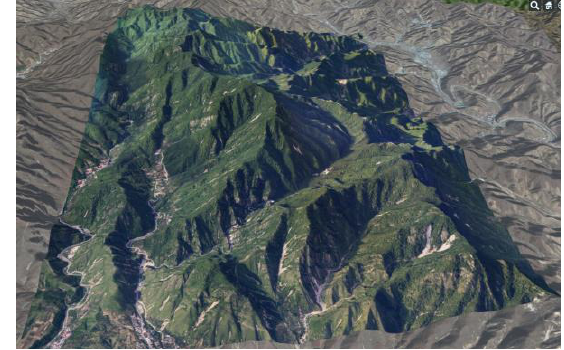
Figure 4. 3D visualization of surveying area B The aerial images were taken by a Nikon D810 camera with a 35mm fixed focal lens during a flight in autumn 2016. The flight height was about 1500 meters above the sea level.